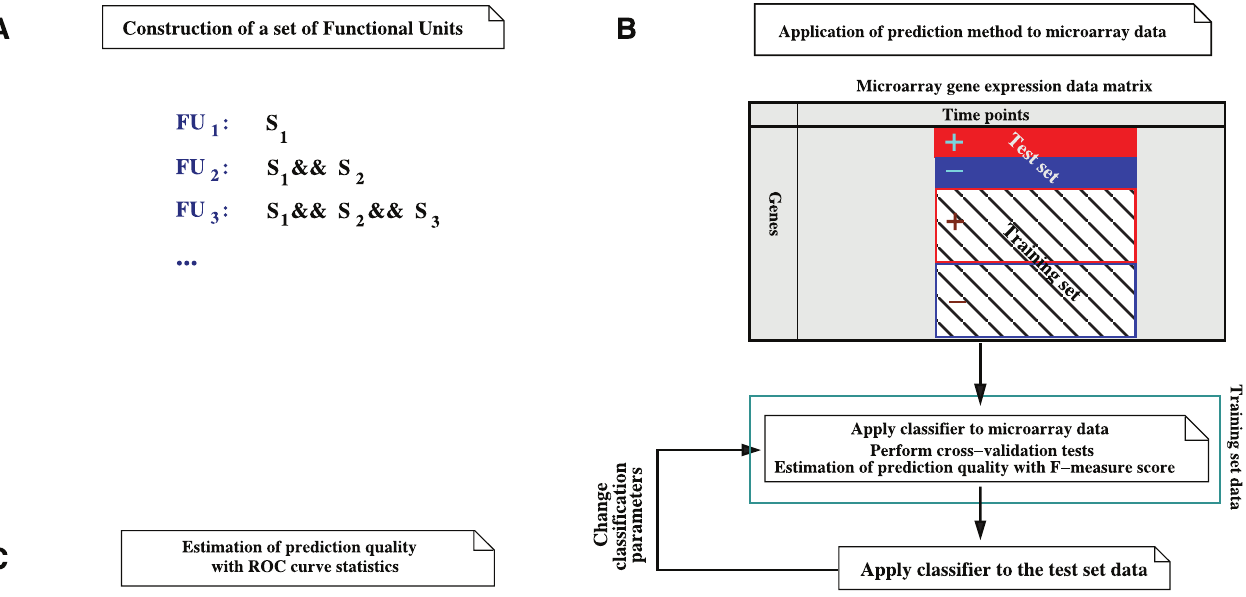
Figure 4. The Three-Stage Computational